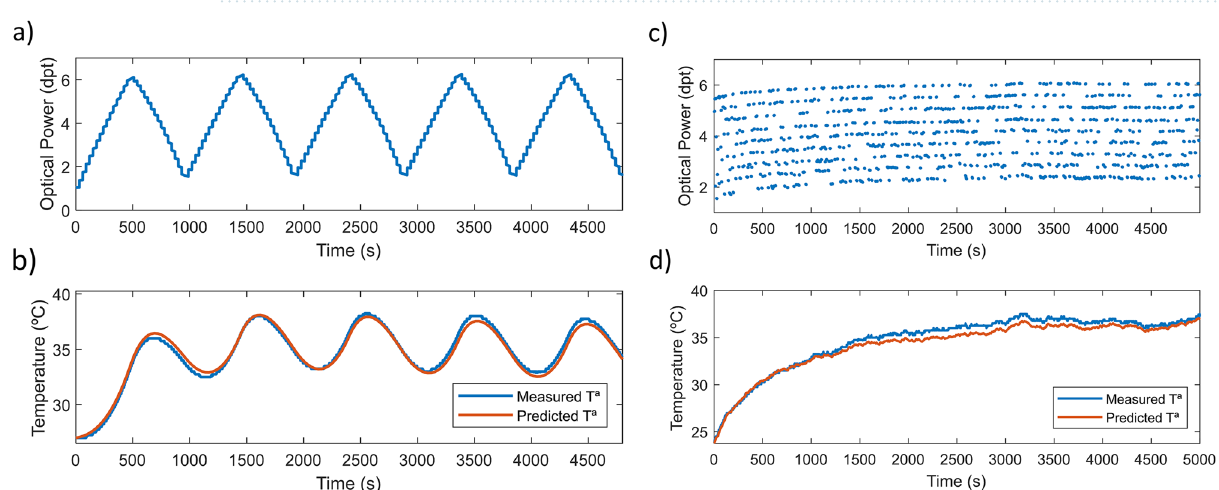
Figure 9. Prediction of internal temperature evolution of a TL in response to different power profiles. ( a ) Measured optical power during hysteresis experiment. ( b ) Measured internal temperature (in blue) and calculated prediction (red) for hysteresis. ( c ) Optical power profile for random experiment and the resulting internal temperature variation ( d ), measured (blue) and predicted